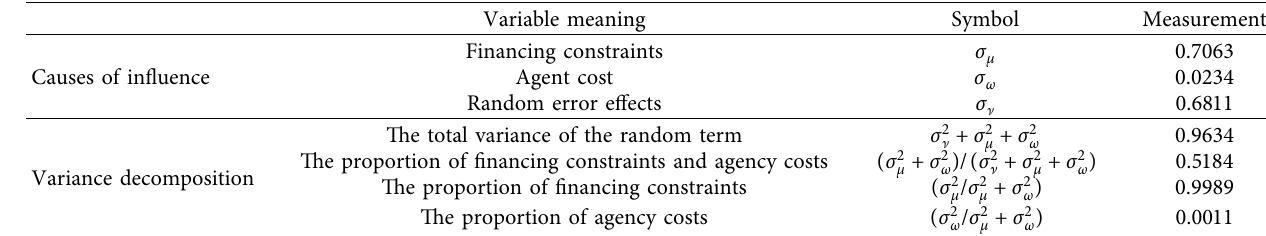
Table 4: Te impact of fnancing constraints and agency costs on investment efciency.